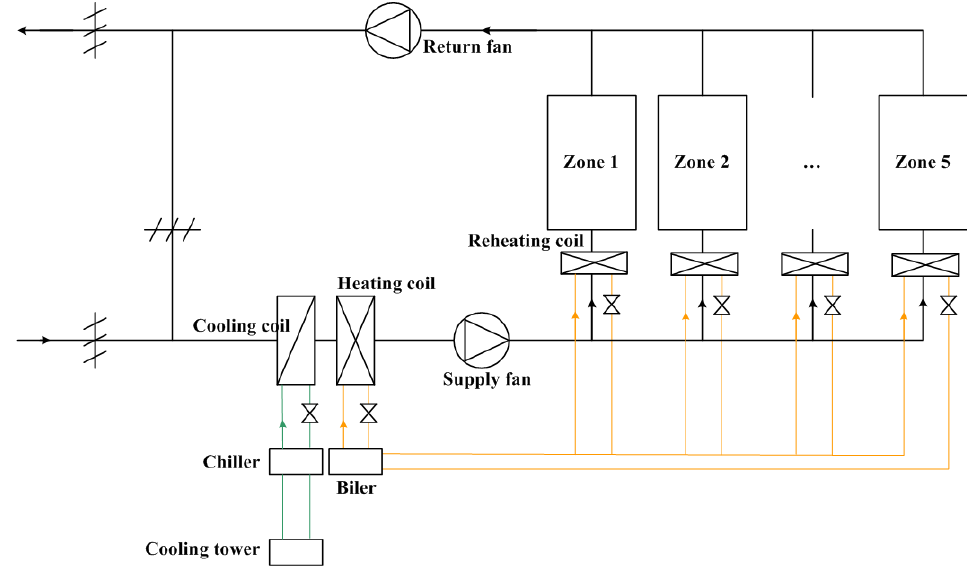
Figure 3. System diagram.